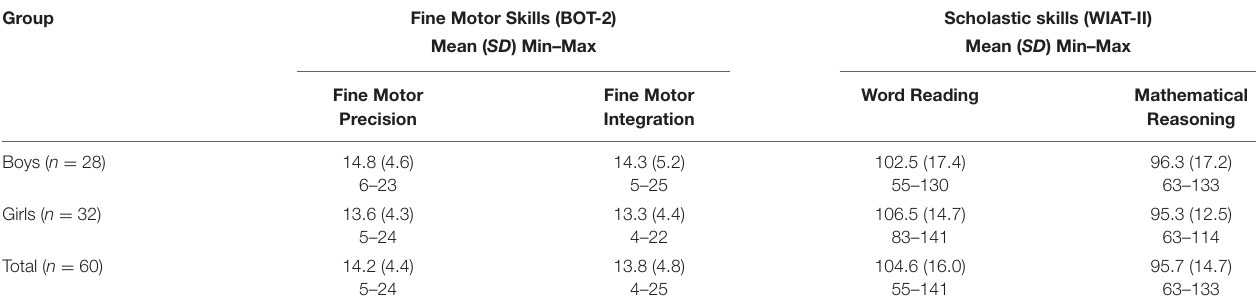
TABLE 1 | Study 1.